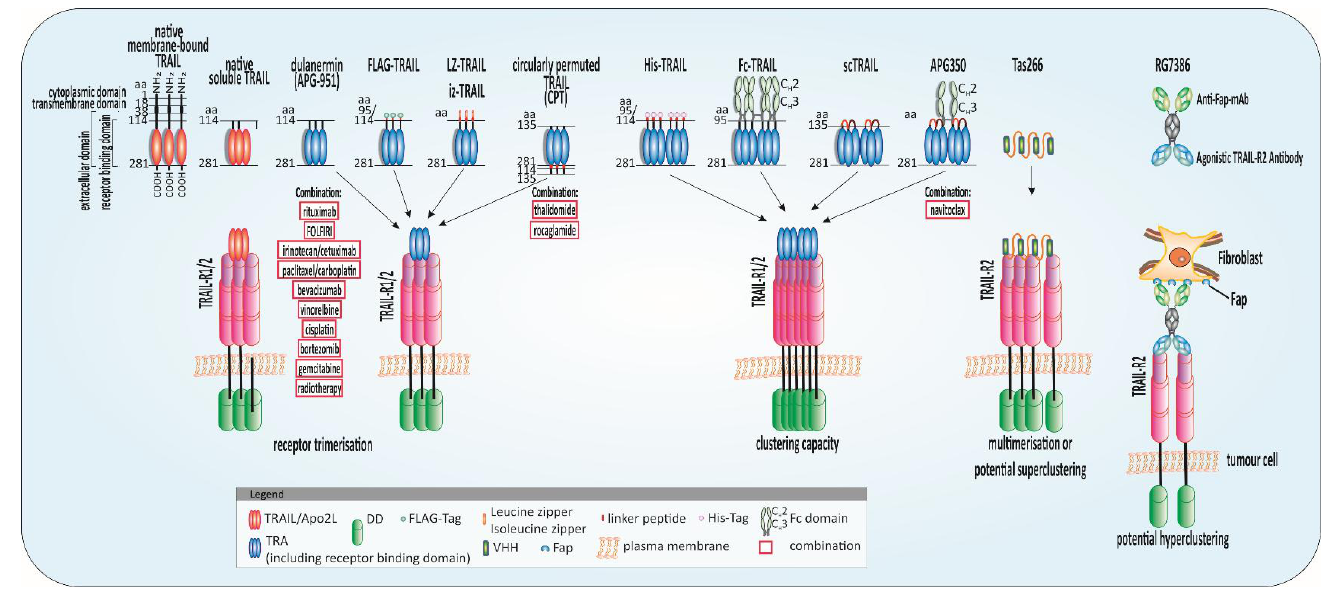
Figure 2. Highly potent TRAIL receptor agonists (TRAs) and combinatorial approaches. Schematic illustration of native tumour-necrosis-factor-related apoptosis-inducing ligand (TRAIL) and potent TRAs evaluated in clinical studies or with promising results in preclinical experiments and their combination with anticancer approaches: native membrane-bound TRAIL is a protein of 281 amino acids (aa) comprising a cytoplasmic domain (aa 1–17), a transmembrane domain (aa 18–38), and an extracellular domain (aa 39–281). The receptor-binding domain (aa 114–281) is located in the extracellular portion [1] which is cleaved from the cell surface to form bell-shaped homo-trimers. Recombinant human TRAIL/Apo2L (dulanermin) is based on the amino acids 114-281 of the extracellular portion of TRAIL [4]. The patients’ benefit in clinical trials was merely marginal even combined with chemotherapeutic regimens such as FOLFIRI (folinic acid, fluorouracil, irinotecan) [93,94]. Tags at the N-terminus of the extracellular domain of TRAIL such as FLAG and poly-histidine (His) aid purification of the ligand and leucine zipper (LZ) and isoleucine zipper (iz) stabilize the trimers [3,120]. Circularly permuted TRAIL (CPT) consists of the N-terminal amino acids 121-135 linked to the C-terminal amino acids 135-281 of TRAIL via a flexible linker [121]. To achieve the fragment crystallizable region (Fc)-TRAIL fusion protein, the Fc portion of human immunoglobulin G1 (IgG1) was fused to the N-terminus of human TRAIL (aa 95 to 281) [122]. Single-chain TRAIL (scTRAIL) is assembled by 3 extracellular domains of TRAIL that are covalently connected by 2 short peptide sequences [123]. APG350 was developed by the fusion of scTRAIL and the Fc-part of a human IgG1 leading to six receptor binding sites per drug molecule [124]. TAS266 comprises four humanised high-affinity heavy chain domain (VHH) antibody fragments which enable clustering of four TRAIL-R2s [117]. The substance caused severe hepatoxicity in clinical phase I studies. The tetravalent fibroblast-activation protein (FAP)-TRAIL-R2 antibody RG7386, targets cancer-associated fibroblasts in the tumour stroma and TRAIL-R2 on tumour cells simultaneously thereby inducing higher-order clustering and apoptosis induction in vitro and animal models [125].